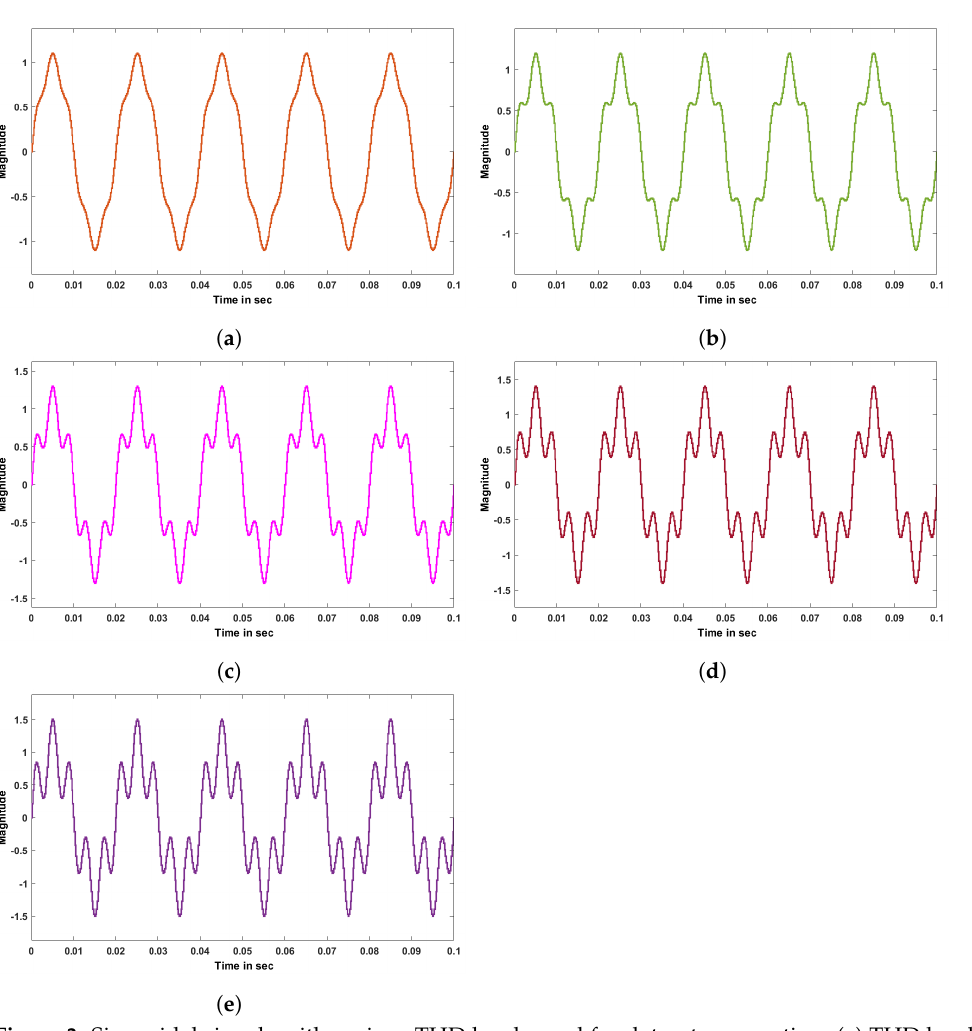
Figure 3. Sinusoidal signals with various THD levels used for dataset preparation. ( a ) THD